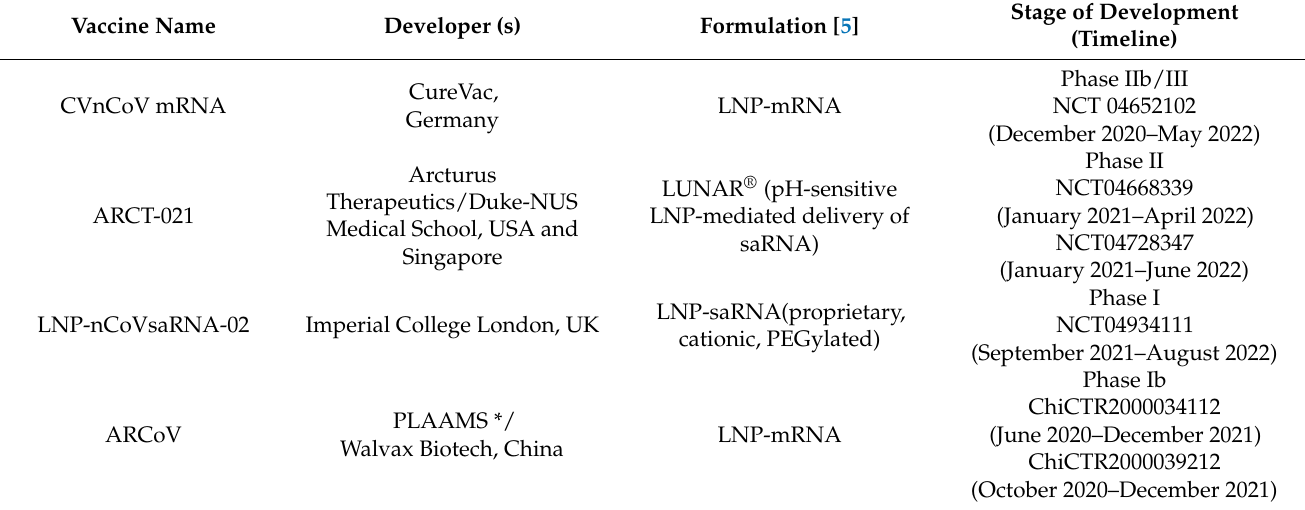
Table 1. Examples of mRNA vaccines against COVID-19 at various stages of development (updated on 4 August